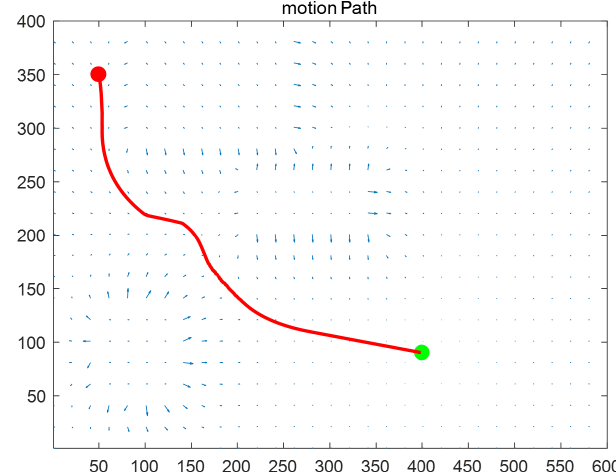
Figure 12. Projection trajectory of improved APF in XOY plane of robot. Table 1. Performance comparison of path-planning algorithms in the simulation